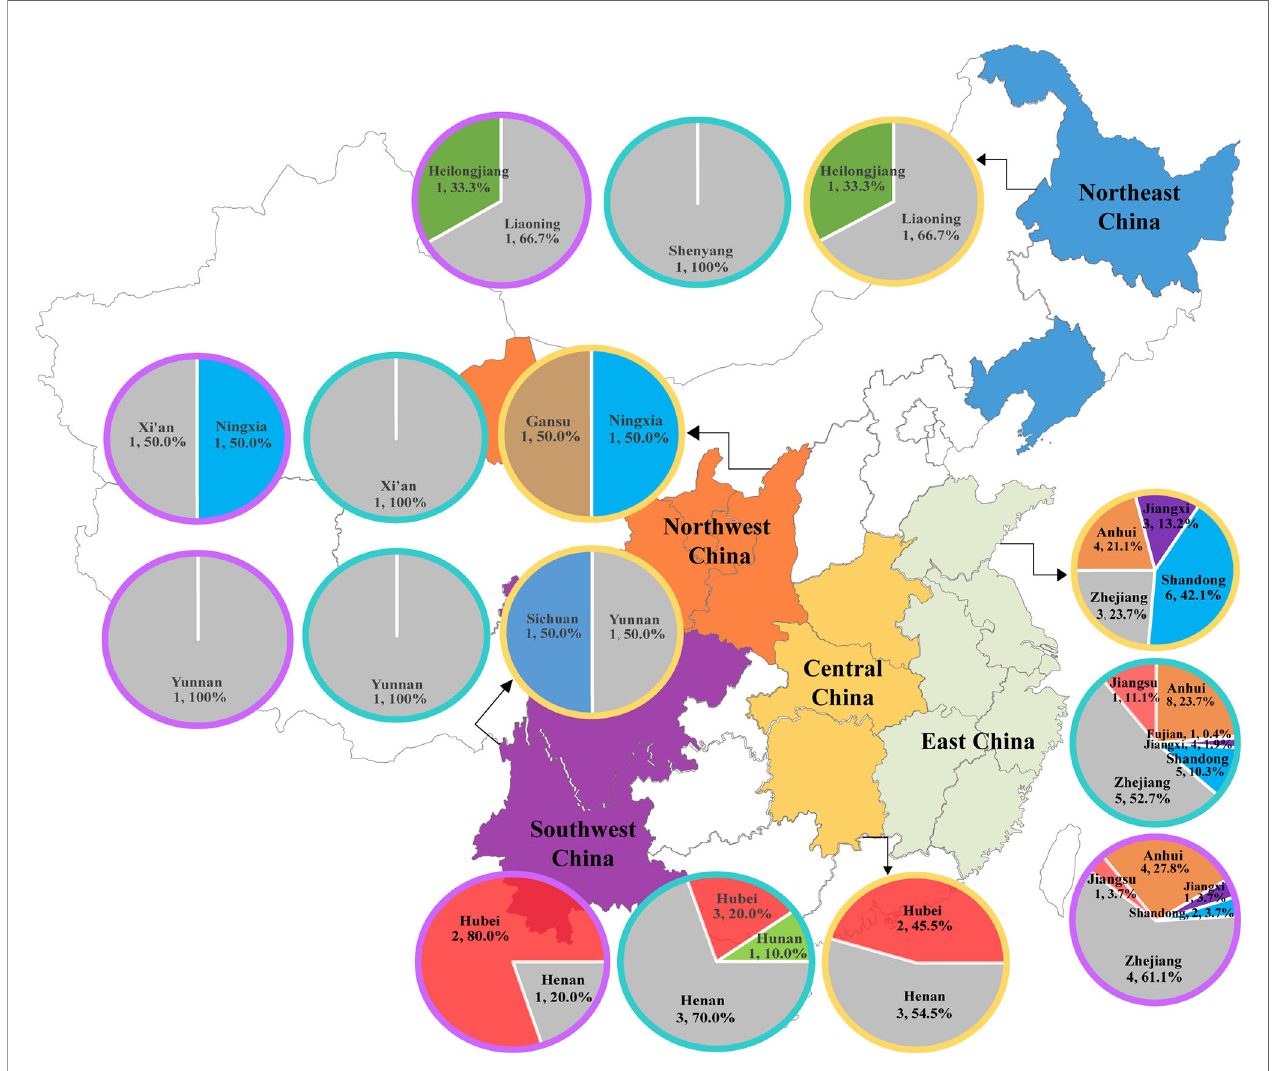
FIGURE 1 | Distribution of bloodstream infections (BSIs) due to carbapenem-resistant organisms (CROs) in China. The description included the regions, number of hospitals, and the proportions of isolates in the corresponding regions. CR-Eco , carbapenem-resistant Escherichia coli ; CR-Kpn , carbapenem-resistant Klebsiella pneumoniae ; CR-Pae , carbapenem-resistant Pseudomonas aeruginosa . Yellow circle , CR-Eco; blue circle , CR-Kpn; purple circle ,